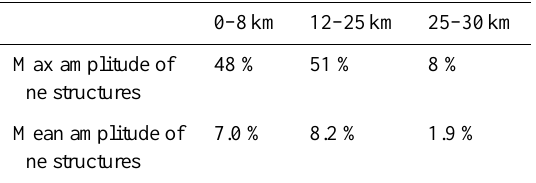
Amplitude of the relative fluctuations of ozone concentration. Mean values over 11-year time series are